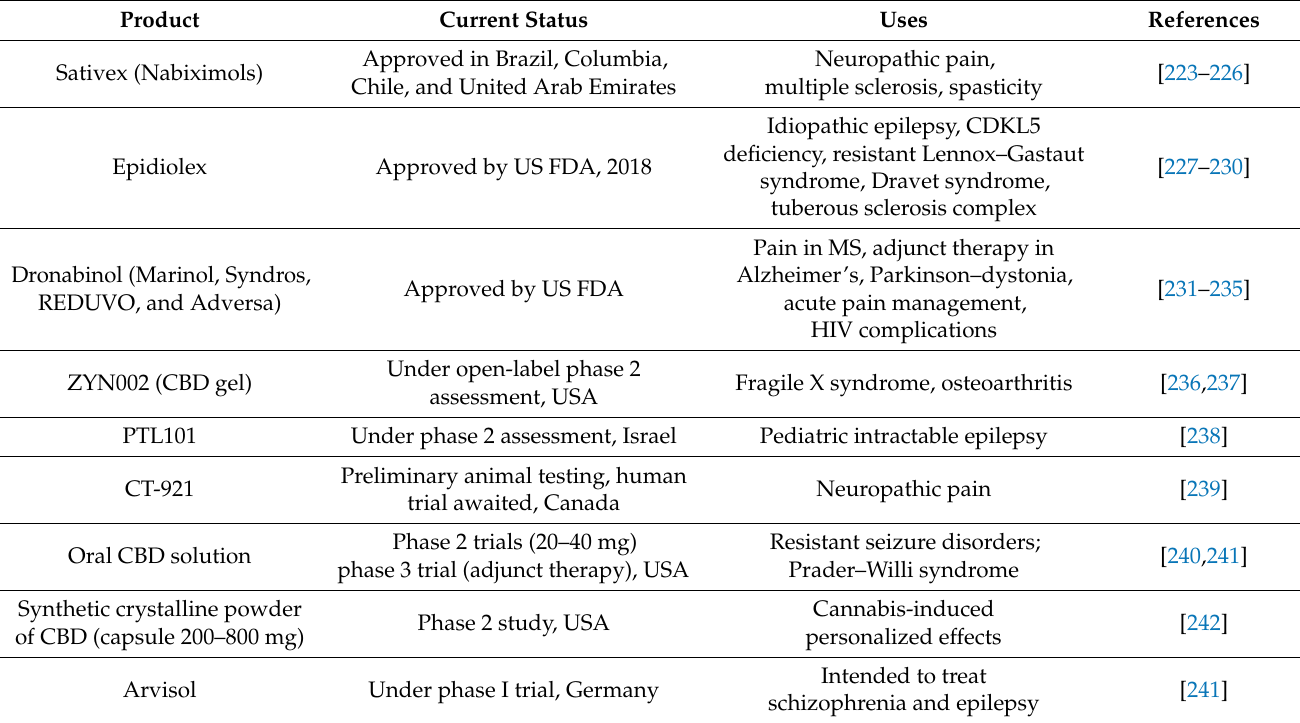
Table 1. Current regulatory status of cannabis-based formulations and their